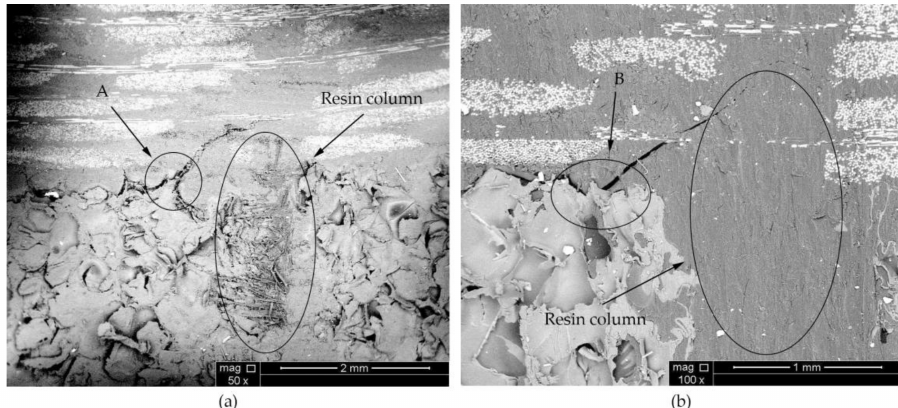
Figure 8. SEM images of ( a ) FH-6, ( b ) FH-8 specimen with cracks deflected by the resin column (A and B are the deflection points).